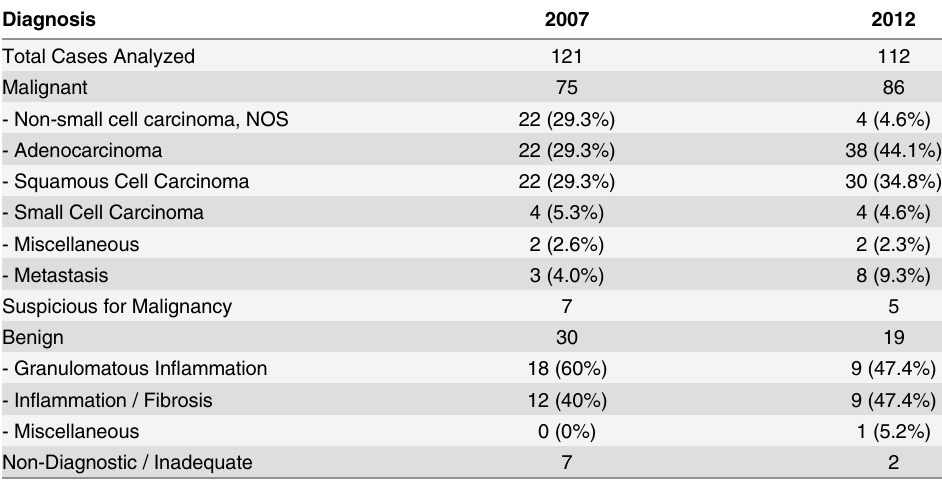
Table 3. Biopsy Diagnosis